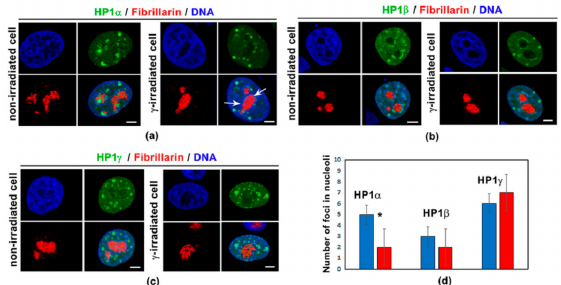
Figure 1. Nuclear distribution pattern of heterochromatin protein 1 (HP1) isoforms in non-irradiated and γ -irradiated human cervix adenocarcinoma (HeLa) cells. Morphology of ( a ) HP1 α (see GFP-tagged HP1 α , green), ( b ) HP1 β (see GFP-tagged HP1 β , green), and ( c ) HP1 γ (see GFP-tagged HP1 γ , green) was studied by laser scanning confocal microscopy. The HP1-positive foci (green) were analyzed in the vicinity of fibrillarin-positive regions of nucleoli (red fluorescence signals). DAPI staining (blue) was used for visualization of nuclei. Scale bars show 5 µ m. ( d ) Analysis of the number of HP1 α -, HP1 β -, and HP1 γ -positive foci in non-irradiated and γ -irradiated (5 Gy) cells. Cells were fixed for analysis 2 h after γ -irradiation. Fifty cell nuclei per sample were studied. Asterisk in panel (d) shows significantly di ff erent